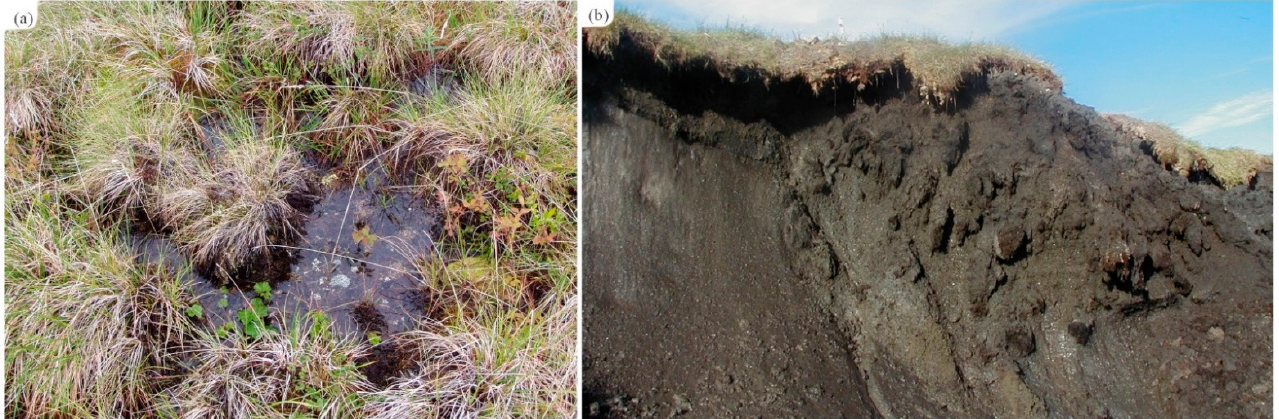
Figure 7. Boggy sediment: ( a ) moss and tussocks sedges in tundra, Dempster Hwy, Yukon, ( b ) peat tussocks, top of Mamontovy Khayata section, Bykovsky Peninsula, northern Yakutia.